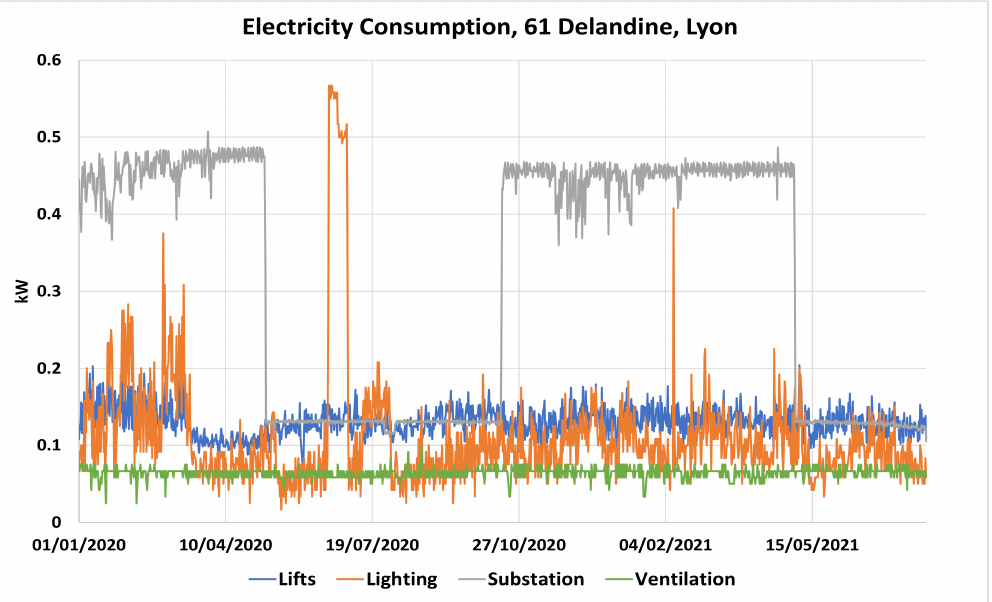
Figure 12. Monitoring data of electricity consumption of elevators, lighting, substations and ventila- tion, 61 Delandine,